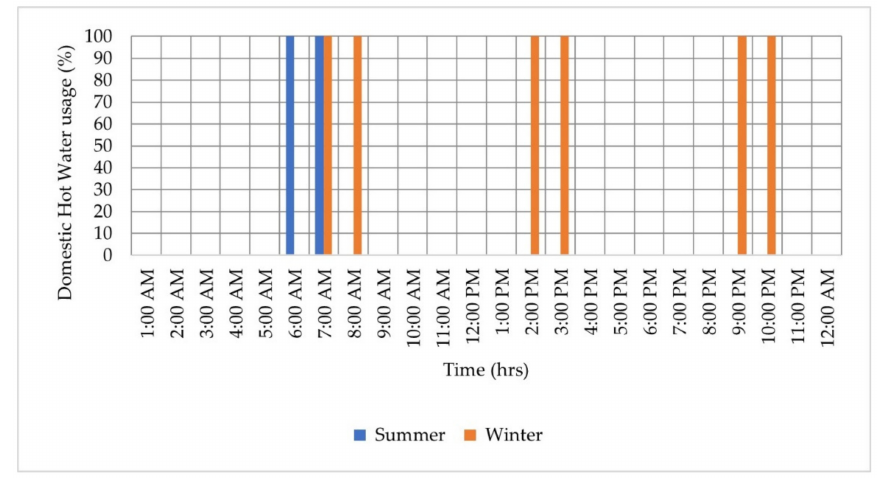
Figure A4. Domestic Hot Water schedule.